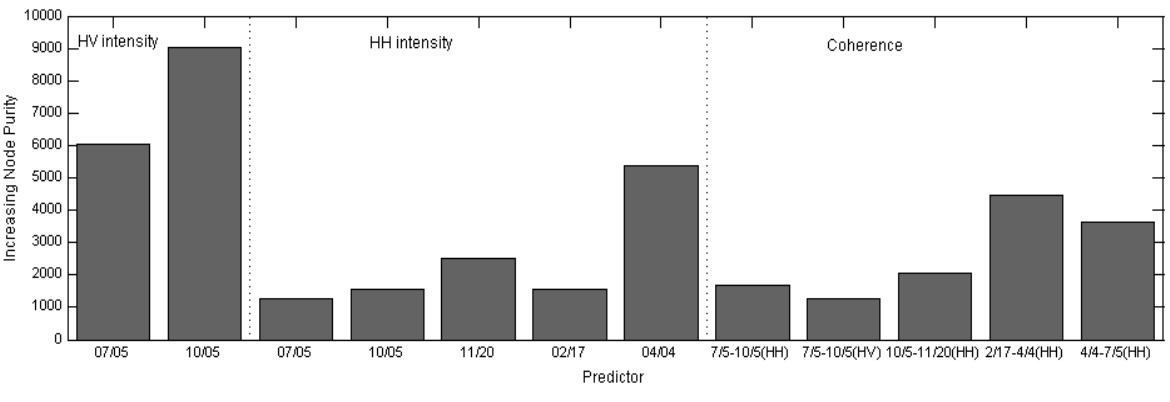
Figure 8. randomForest predictor importance ranking for the retrieval of CH using all ALOS PALSAR imagery available at test site